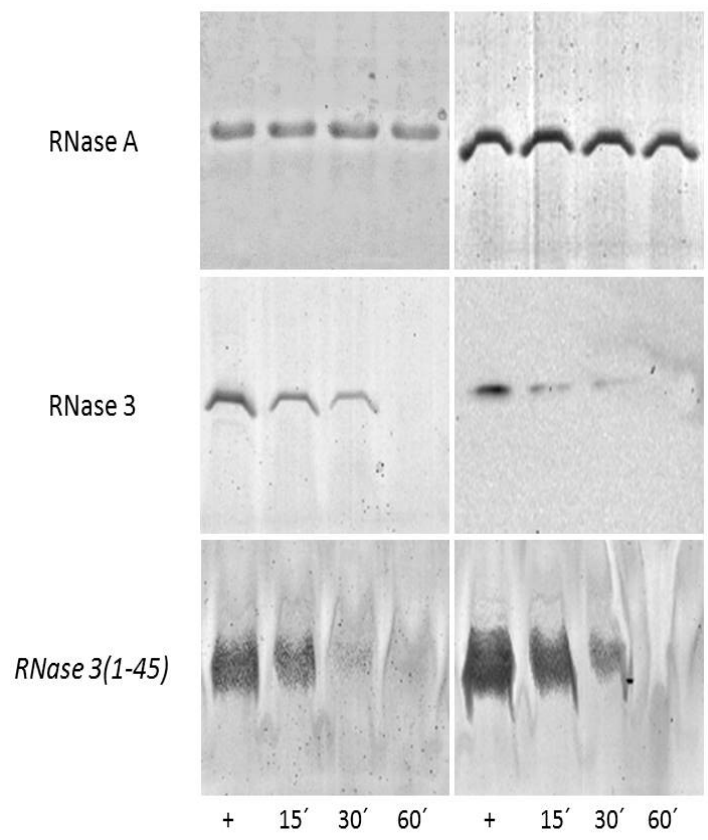
Figure 2. Binding of hRNase3 peptide to C. albicans cells (left panels) and β - d -Glucans (right panels). RNase A was taken as a negative control for cell and β - d -Glucan binding, respectively. C. albicans cells and β - d -Glucan were incubated at di ff erent time (15, 30 and 60 min) with the protein and RN3 peptide: hRNase3(1–45). The supernatant soluble fractions were prepared as described in the Experimental Procedures. Supernatant represents the soluble fraction, which contains the unbound protein / peptide. 15% and 18% SDS-PAGE were respectively used to separate the protein and peptide fractions. Protein and peptide alone were also loaded to the gel as positive controls (+).